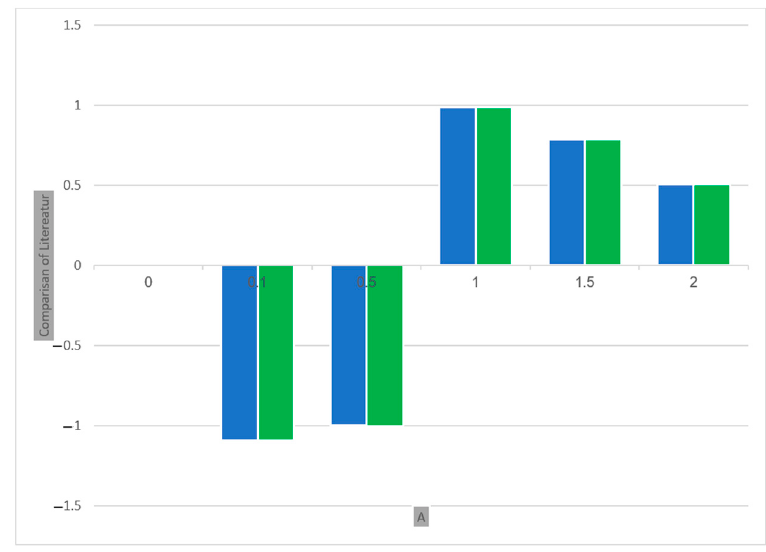
Figure 2. Comparison of this outcome vs. previous literature [1].